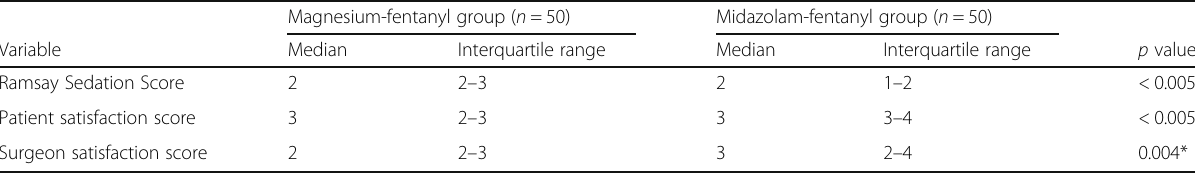
Table 5 Ramsay Sedation Score and patient and surgeon satisfaction scores in both study groups Magnesium-fentanyl group ( n = 50)